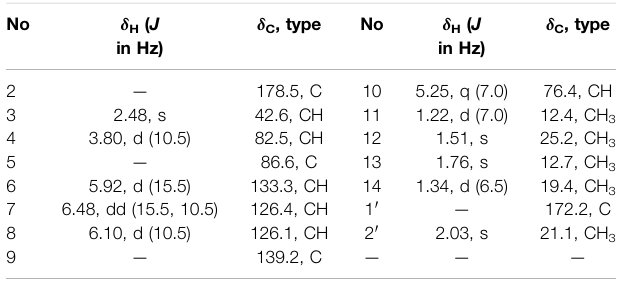
TABLE 2 | 1 H (500 MHz) and 13 C (125 MHz) NMR spectral data of compounds 3 and 5 in acetone- d 6